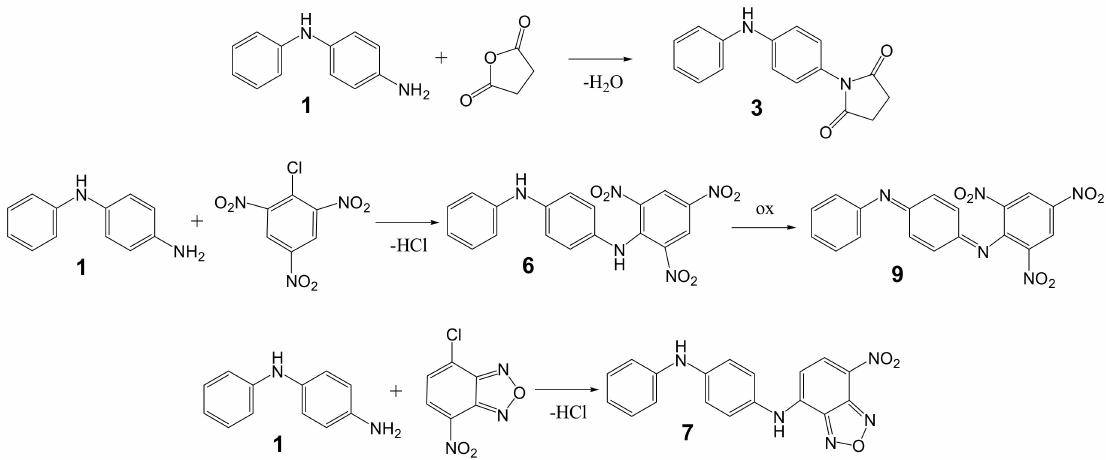
Scheme 1. General procedure for the synthesis of the compounds. Table 2. Experimental and computed values of the compounds 1 – 9